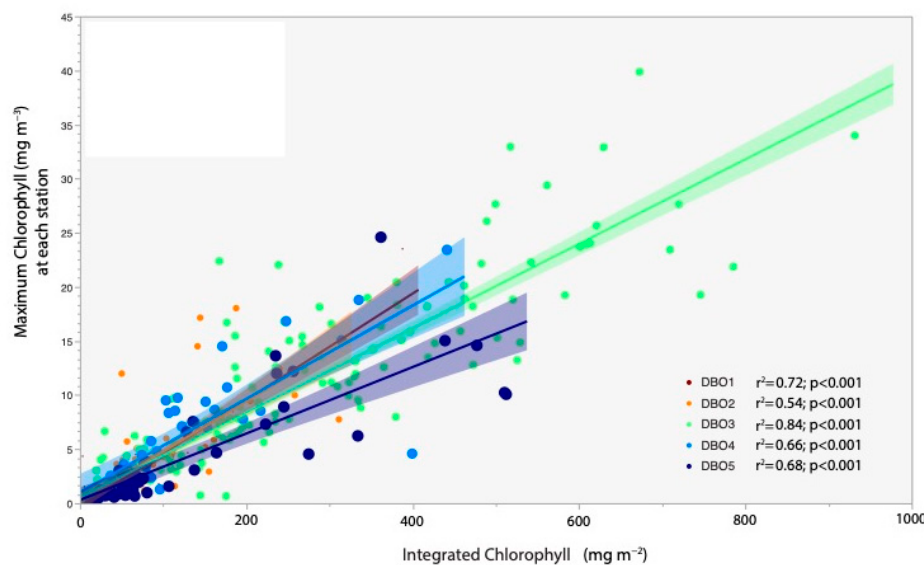
Figure 3. Correlations between integrated chlorophyll over whole water column relative to maxi- mum chlorophyll observed at any specific depth. chlorophyll observed at any specific depth.